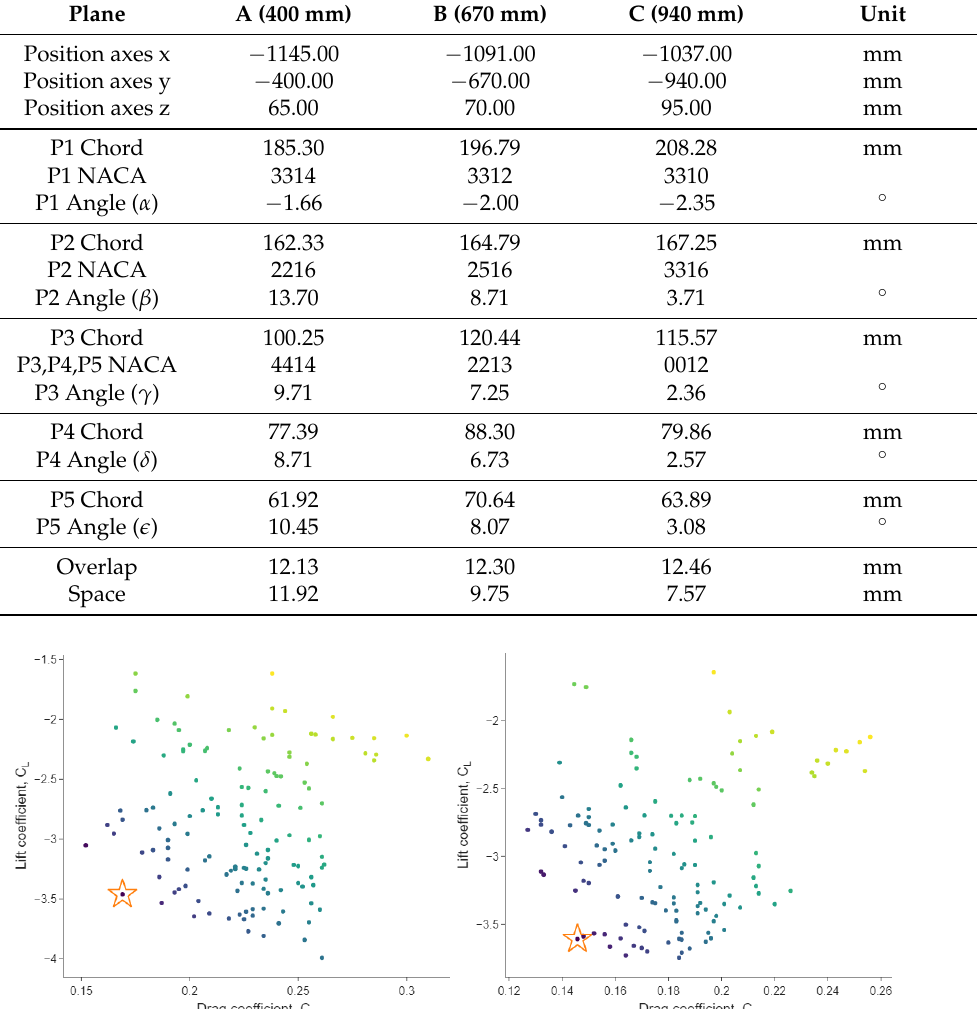
Table 3. Optimal front wing profiles from parametric optimisation.